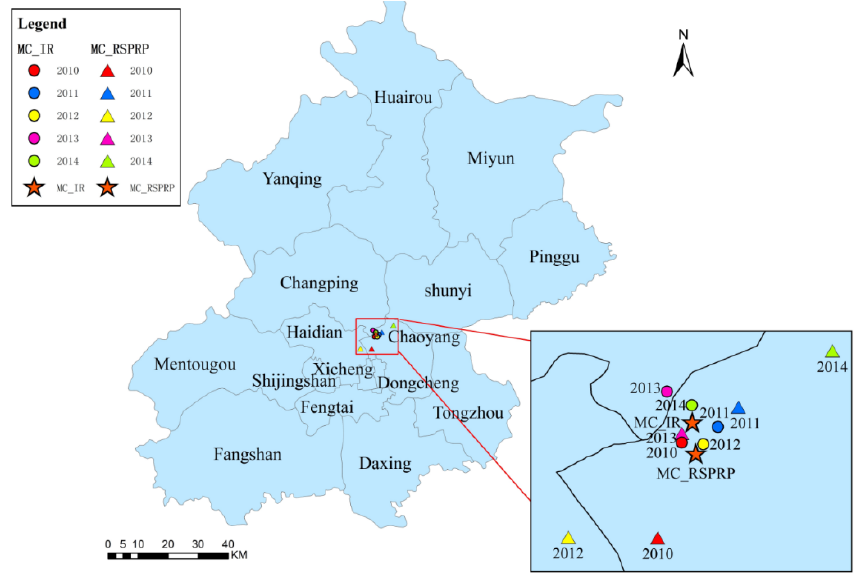
Figure 9. The distributions of IR and RSPRP MC in Beijing from 2010 to 2014.